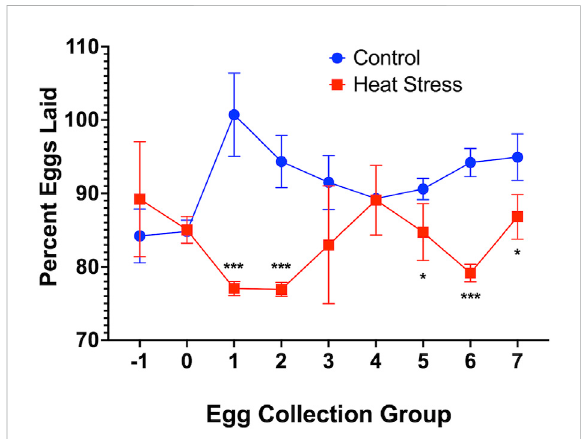
FIGURE 4 Percent Eggs Laid of Ducks Exposed to Cyclic HS (35 ° C for 10h/day and 29.5 ° C for the remaining 14h/day) or control. Data shown are means ± SEM, n = 3/time group and all eggs laid over 3 consecutive days averaged per time group. Ducks exposed to heat stress showed a signi fi cant lower percent of eggs laid compared to the controls at weeks 1 and 3 after onset of treatment. Egg groups relative to week; groups − 1 and 0 (week preceding heat stress), groups 1 and 2 (week 1), groups 3 and 4 (week 2), and groups 5, 6 and 7 (week 3). * = p < 0.05, *** = p <